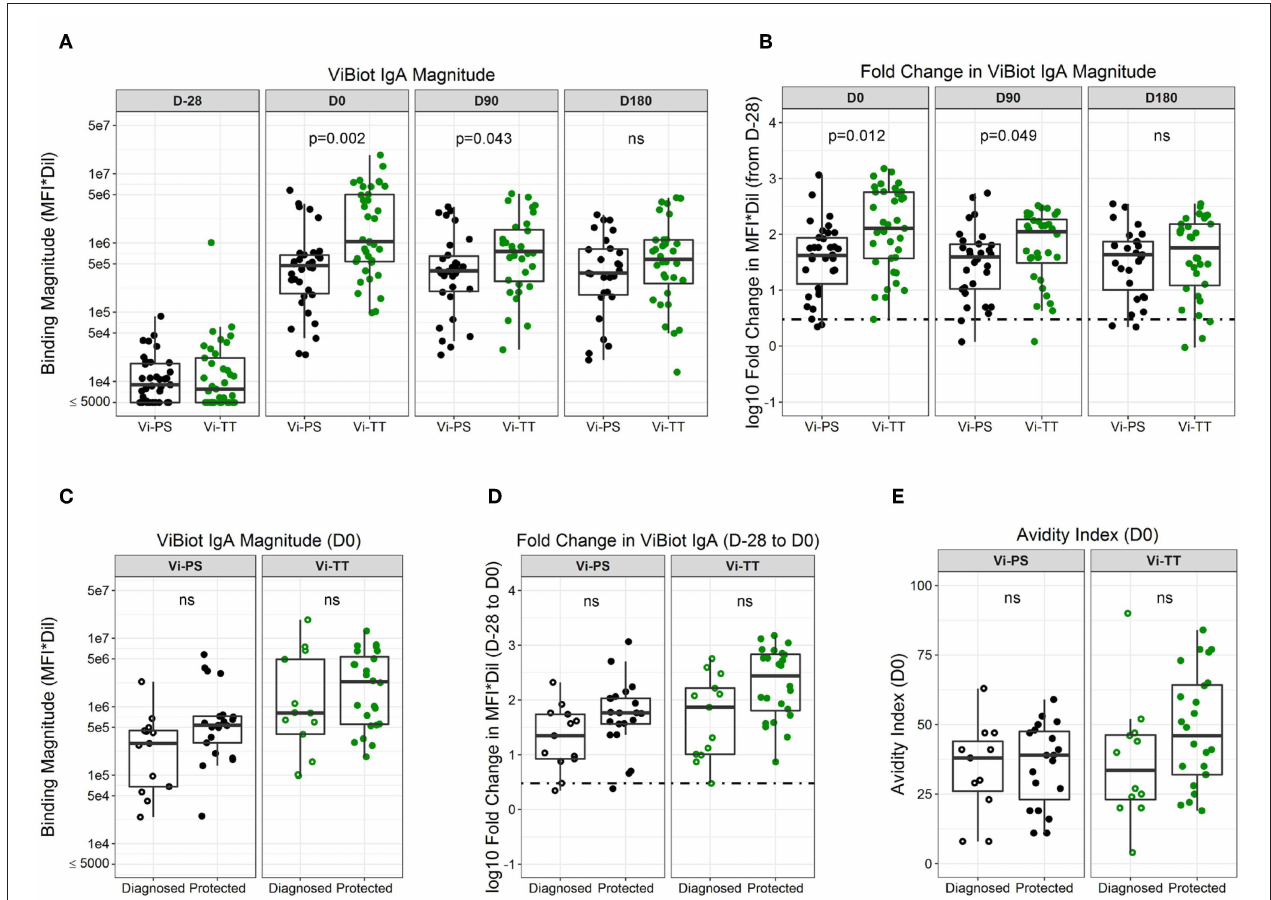
FIGURE 2 | ViBIOT-specific total IgA magnitude, fold change, and avidity higher in protected individuals of both vaccine groups. ViBIOT-specific IgA magnitude (A) and fold change (B) by vaccine group over time. ViBIOT-specific IgA magnitude (C) and fold change (D) by diagnosed/protected outcome at day of challenge. ViBIOT IgA avidity index (E) by diagnosed/protected outcome at day of challenge. Diagnosed and protected individuals are represented by open and closed circles, respectively. Data points are representative of n = 2 independent experiments (each with n = 2 technical replicates). n.s indicates non-significant FDR-corrected p